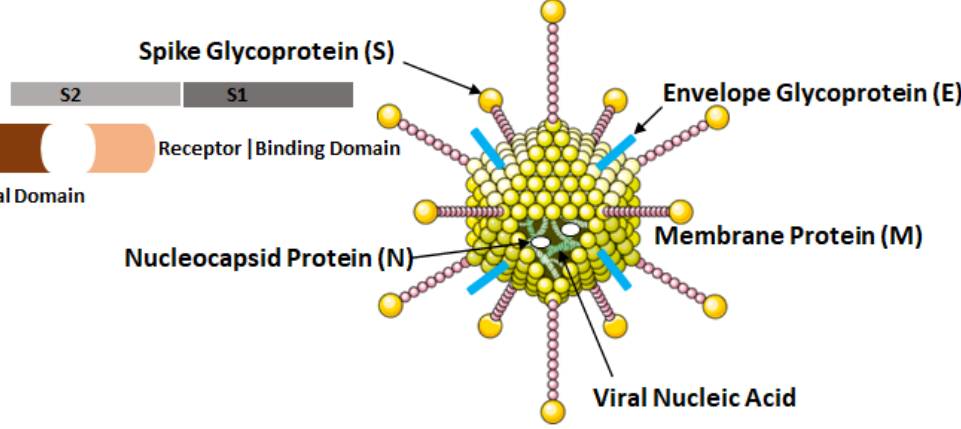
Figure 4. Structural elements of COVID-19 virus, i.e., SARS-CoV-2.